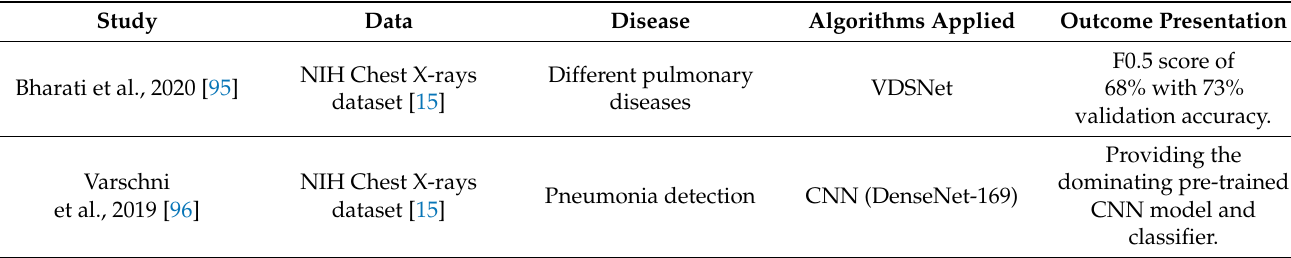
Table 1. Articles included in the review associated with lung